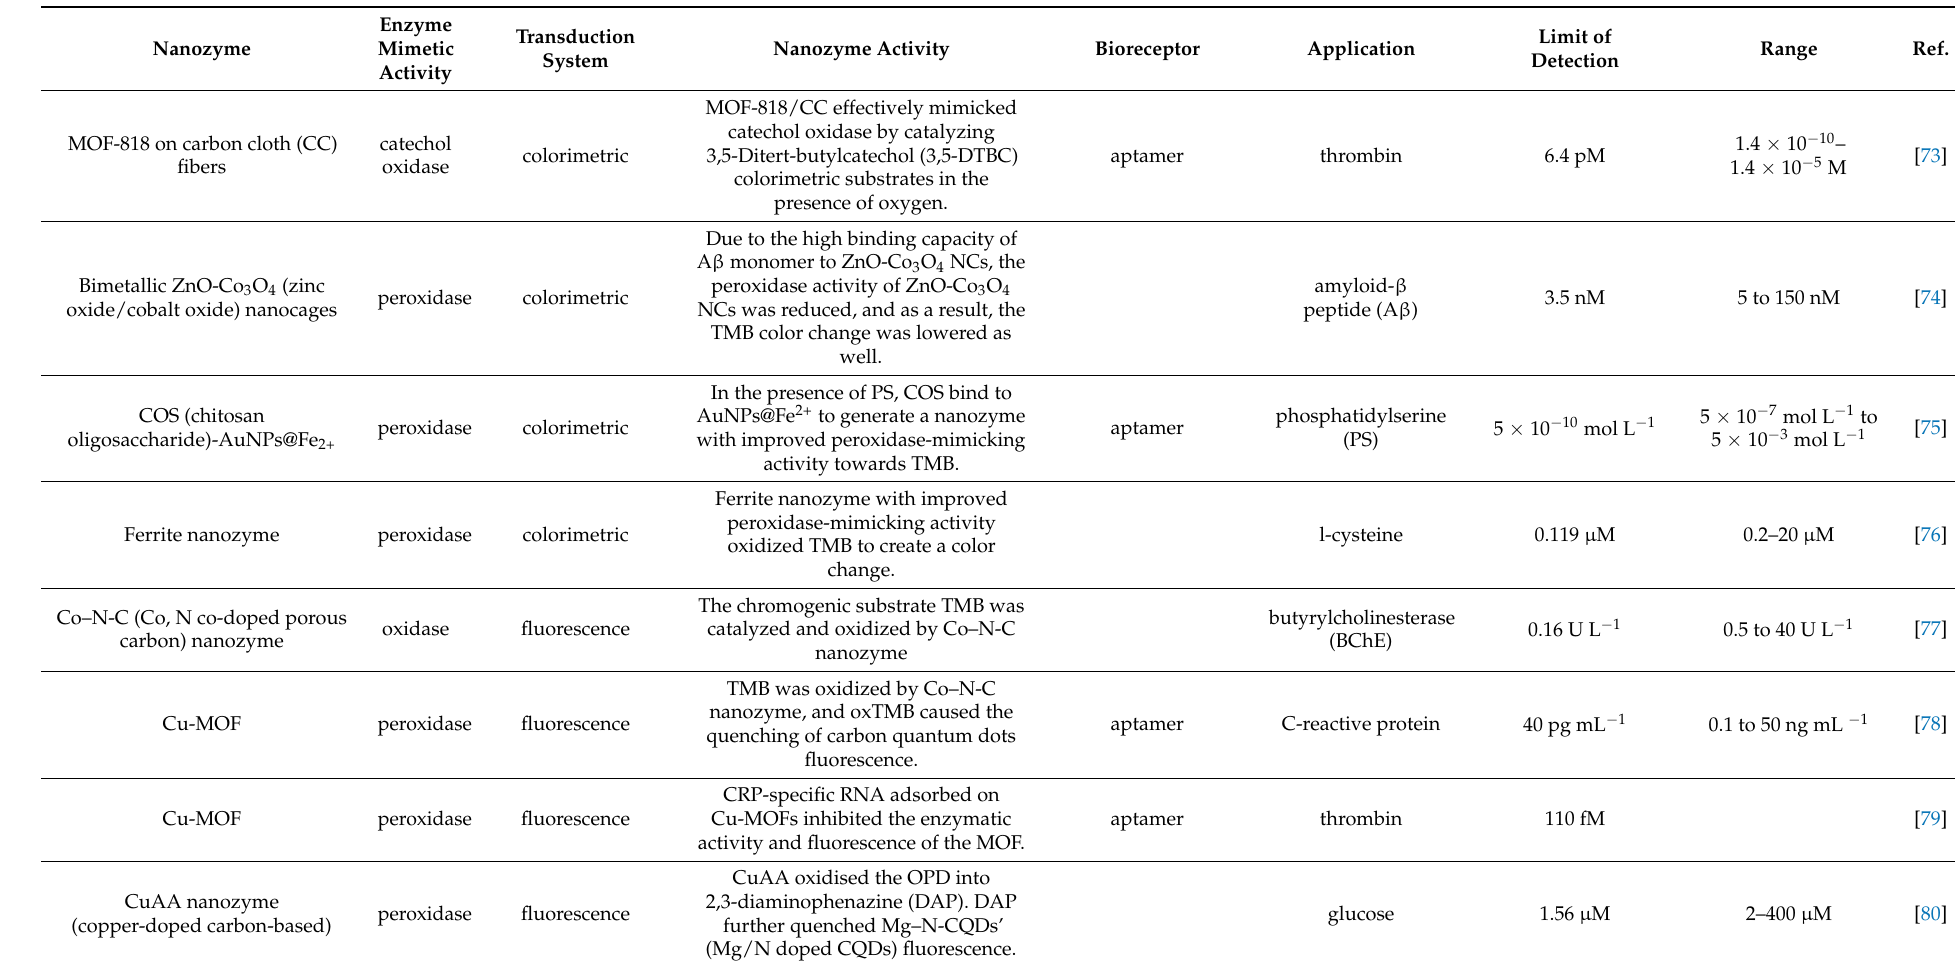
Table 1. Different biosensors based on nanozymes used in biosensing